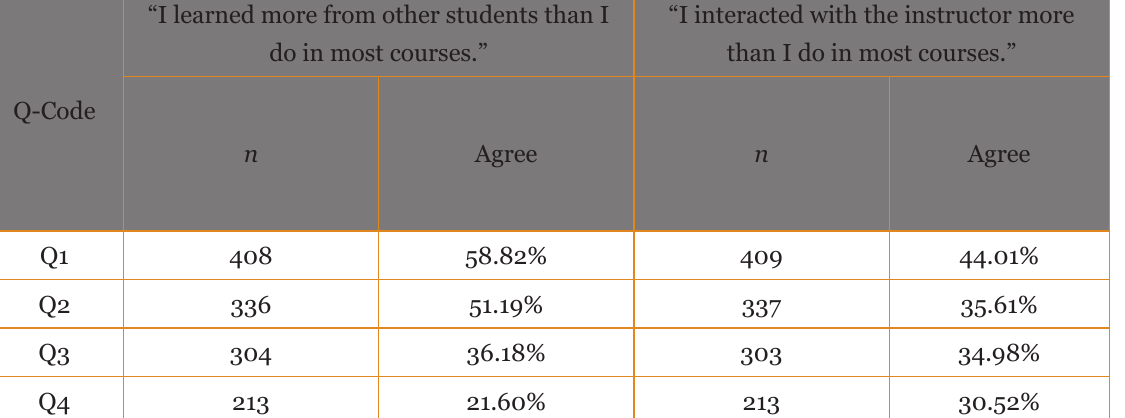
Agreement for Learning from Other Students, Interacting with the Instructor “I learned more from other students than I “I interacted with the instructor more do in most courses.” than I do in most courses.” Q-Code n Agree n Agree